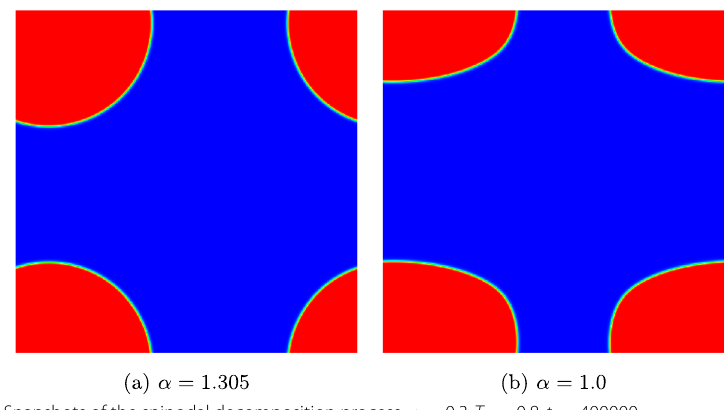
Fig. 19 Snapshots of the spinodal decomposition process, τ = 0.3 , T r = 0.8 , t =